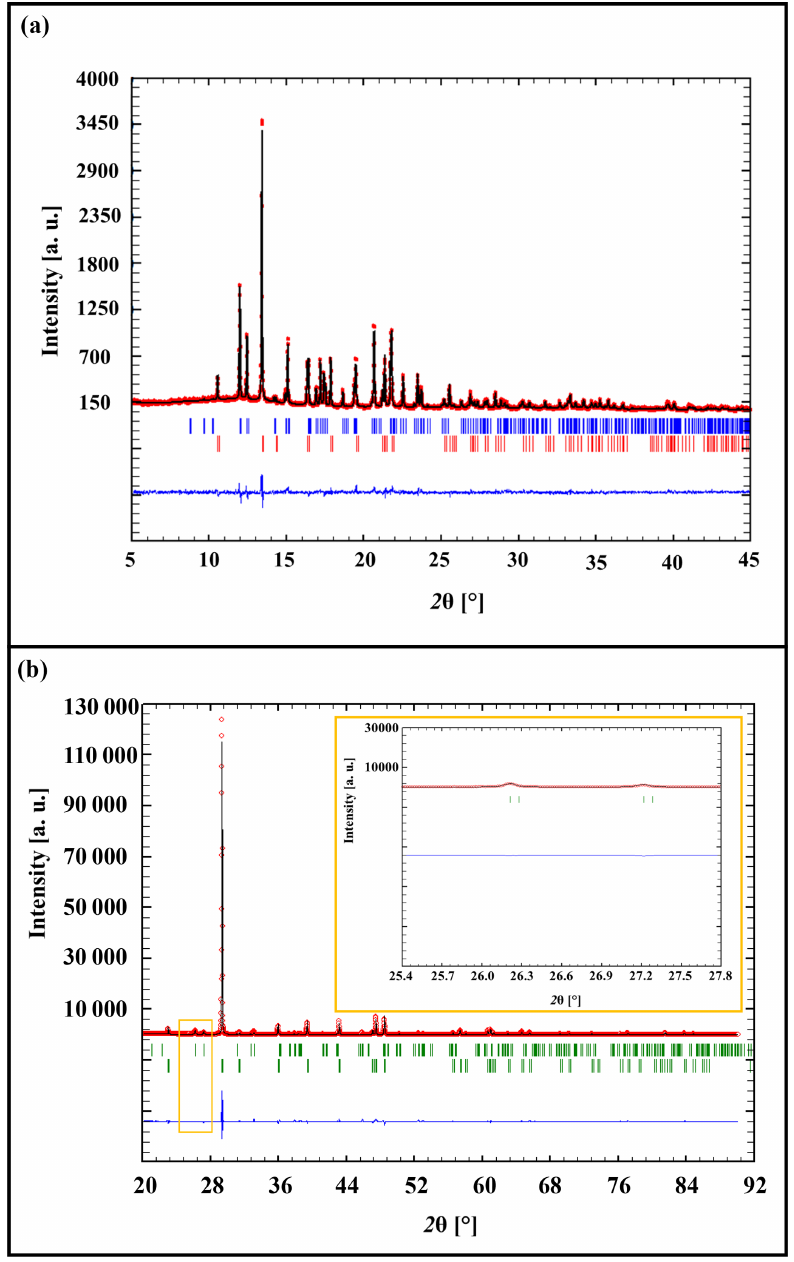
Figure A12. Representative Rietveld plot for the product of the alteration experiment performed at 175 ◦ C for 6 (a) and 84 days (b) in artificial burial solution measured with MoK α 1 in transmission and with CuK α 1 in reflection, respectively. The diffuse amorphous signal peaking near 12.5 ◦ 2 θ is due to the Lindemann glass capillary ( ∅ 0.3mm) containing the